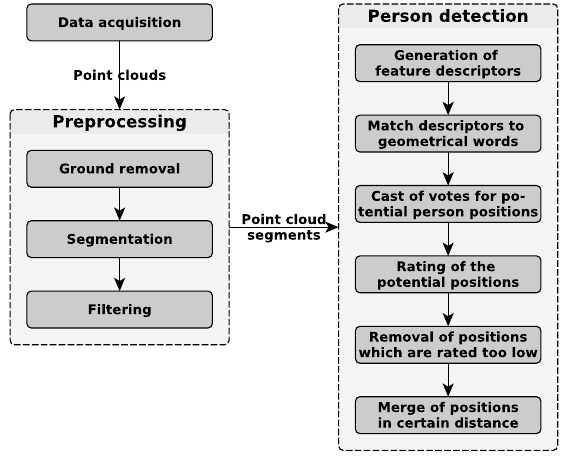
Figure 2. Schematic diagram of our